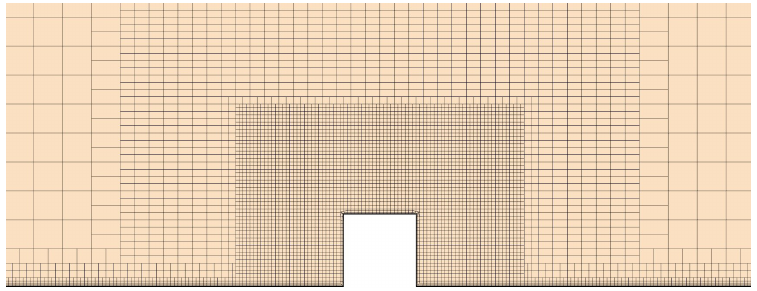
Figure 1. Front View of Meshing Scheme for Surface Mounted Cube.